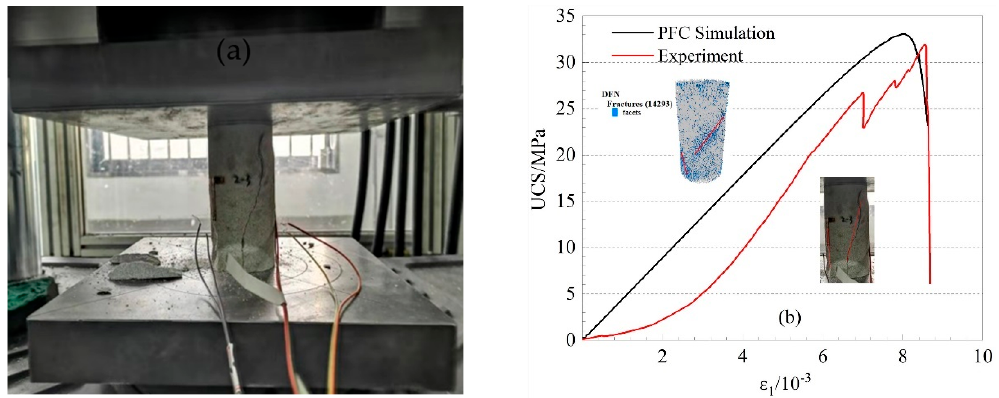
Figure 1. Stress–strain responses of sandy mudstone and DEM model. ( a ) Uniaxial compression test, ( b ) Stress strain curve.